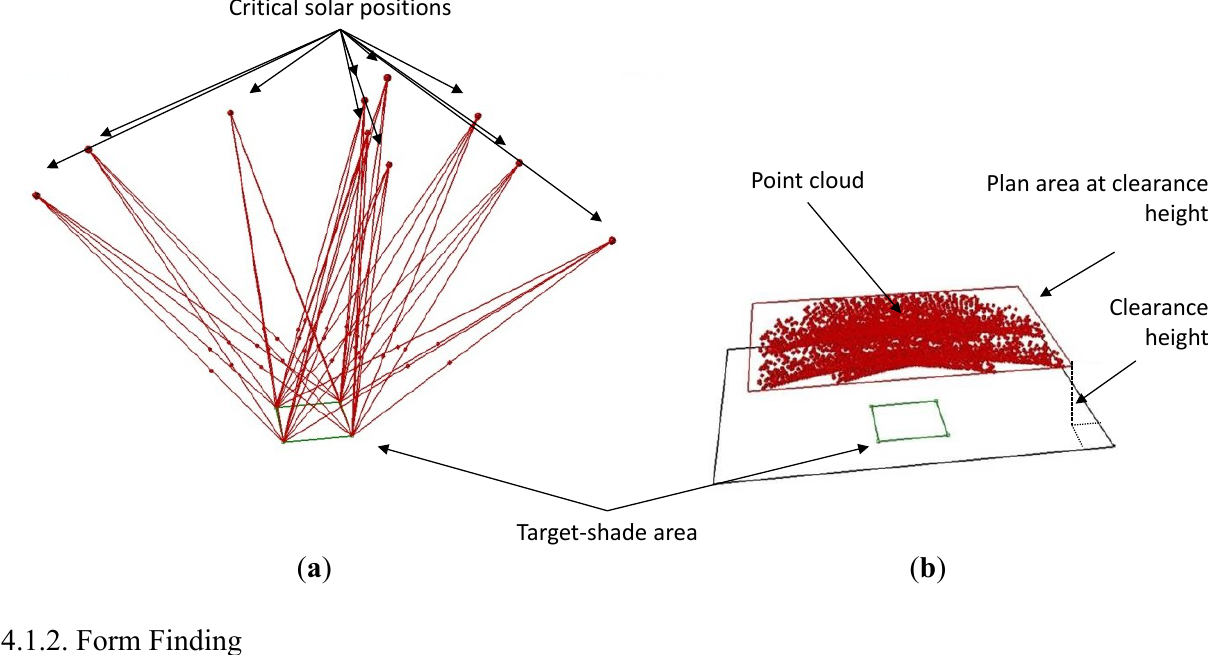
Figure 3. ( a ) Shading analysis establishes the critical solar positions for a dense grid on the target-shade area; ( b ) A contour encompasses the point cloud that lies at the intersection between the critical solar vectors and the plane at clearance height, positioned parallel to ground